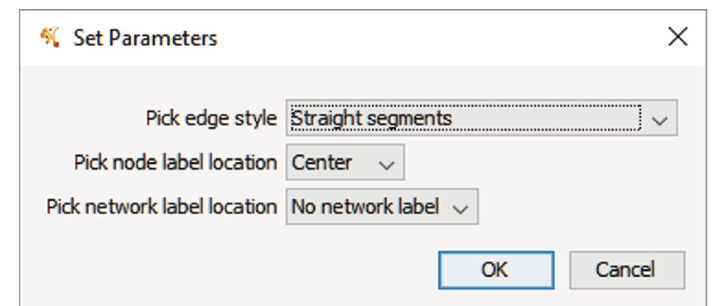
Figure 3. Set Parameter pop-up prompts users with three options.